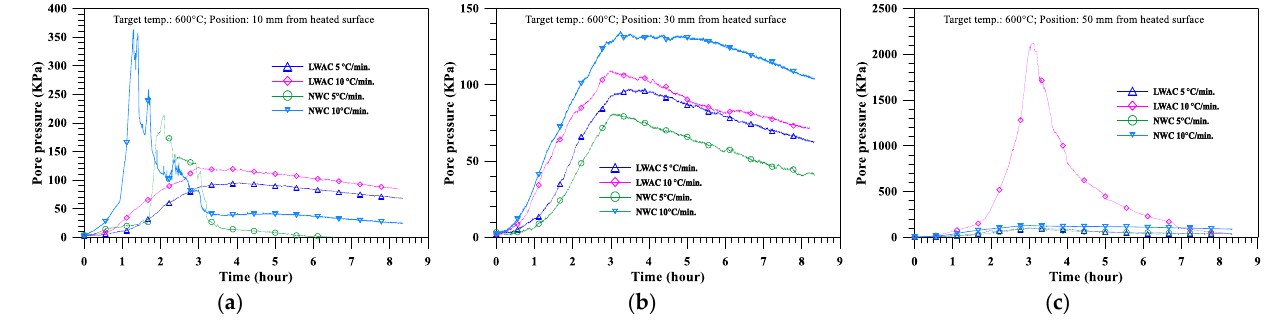
Figure 22. Effect of the heating rate on the pore pressure of the air-dried specimens performed at a target temperature of 600 °C: ( a ) 10; ( b ) 30; ( c ) 50 mm depths.